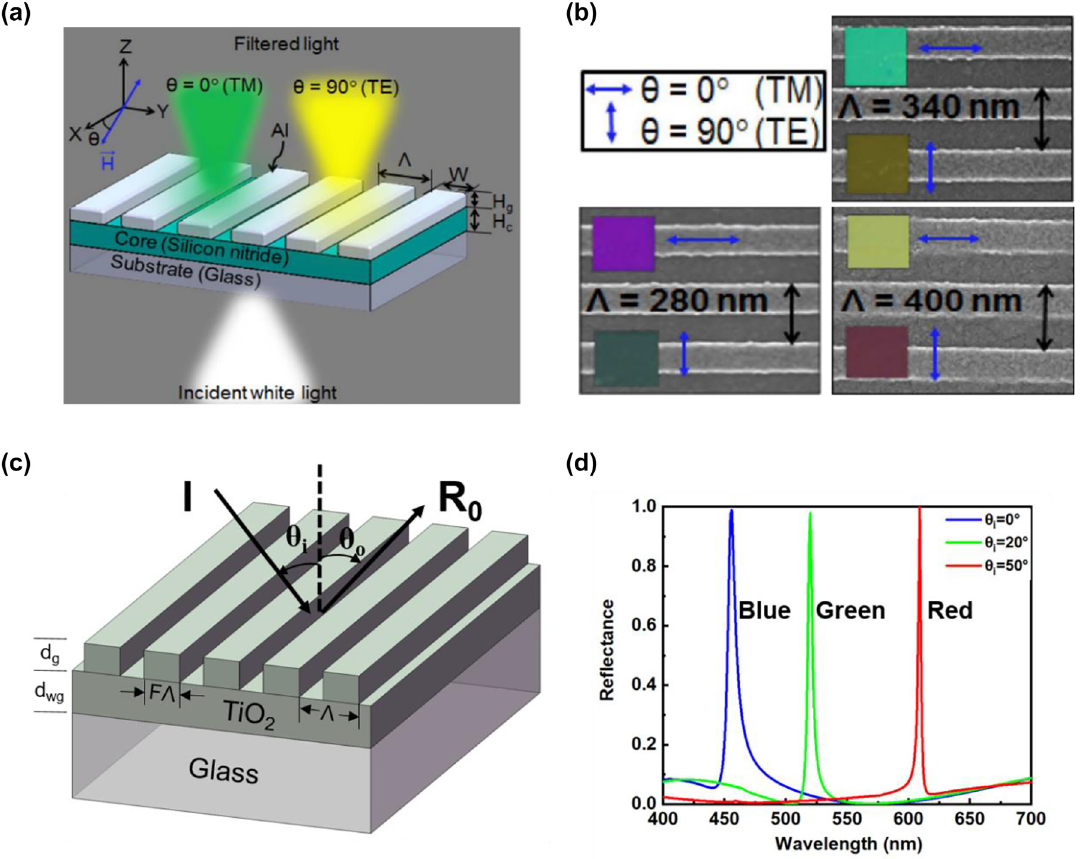
Figure 10: Guided mode resonance for tunable structural color generation. (a) Schematic diagram of a GMR-based nanostructure for ) Al grating layer, a 100-nm thick ( H ) Si N waveguide polarization-dependent structural color generation. The device is composed of a 40 nm thick ( H g C 3 4 layer and a glass substrate. Λ and W represent the period and width of the Al grating. TM polarization refers to the electrical field vector oscillating along 𝜃 = 0 ◦ direction, and TE polarization refers to the electrical field vector oscillating along 𝜃 = 90 ◦ direction. (b) SEM images of fabricated 1D-Al-grating based devices and the associated optical photos under TM- and TE-polarized illumination. Periods of the Al gratings are set as 280 nm, 340 nm, and 400 nm, respectively. The filling ratio is fixed as 0.5 for all samples. Modified with permission [129]. Copyright 2017, Nature Publishing ) TiO Group. (c) Schematic diagram of a GMR-based device for angle-dependent structural color generation. The device consists of a 55 nm thick ( d g 2 grating, a 110 nm thick ( d ) TiO waveguide layer, and a glass substrate. 𝜃 and 𝜃 represent angles of the incidence and reflection, respectively. Here, wg 2 i o is set as 2.2 over the visible range. (d) Calculated reflection spectra under TM polarized illumination (electric field refractive index of the lossless TiO 2 = 50 ◦ , 20 ◦ and 0 ◦ , respectively. The TiO grating has vector orthogonal to the grating). Angles of incidence for red, green, and blue colors are set as 𝜃 i 2 a period of 260 nm and a filling ratio of